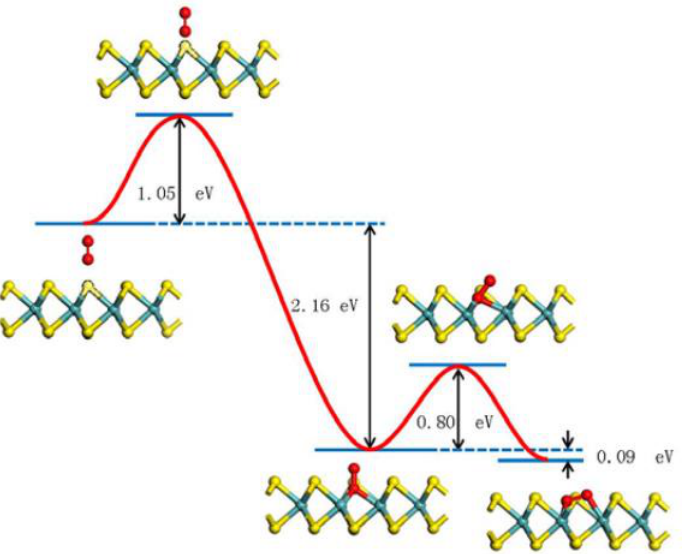
Figure 16. Oxygen dissociative adsorption on MoS 2 basal with SSV according to Nan et al. [79]. The reaction path consists of two steps. In the first step, the physisorbed O 2 approaches MoS 2 sheet and the oxygen atom at the lower end forms chemical bonding with the unsaturated Mo atoms. In the second step, it takes 0.8 eV to accommodate the O 2 from the standing configuration to the lying-down configuration, which has an energy advantage of 0.09 eV. Reprinted from Reference [79], with permission. Copyright 2014 American Chemical